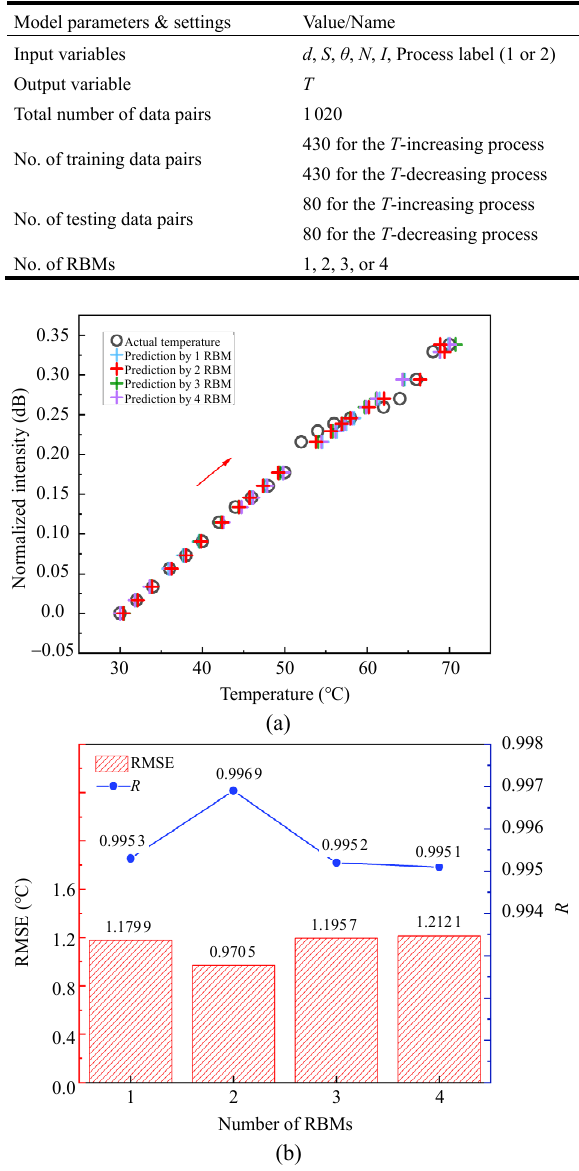
Table 2 DBN settings for temperature prediction by HMF sensor.